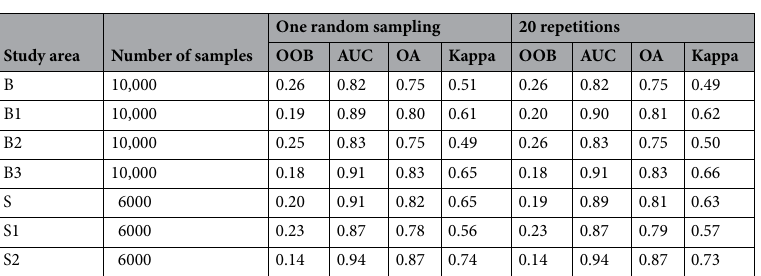
Table 1. Accuracy metrics with a representative number of samples. OOB out-of-bag error, AUC area under the curve, OA overall accuracy, Kappa kappa index of